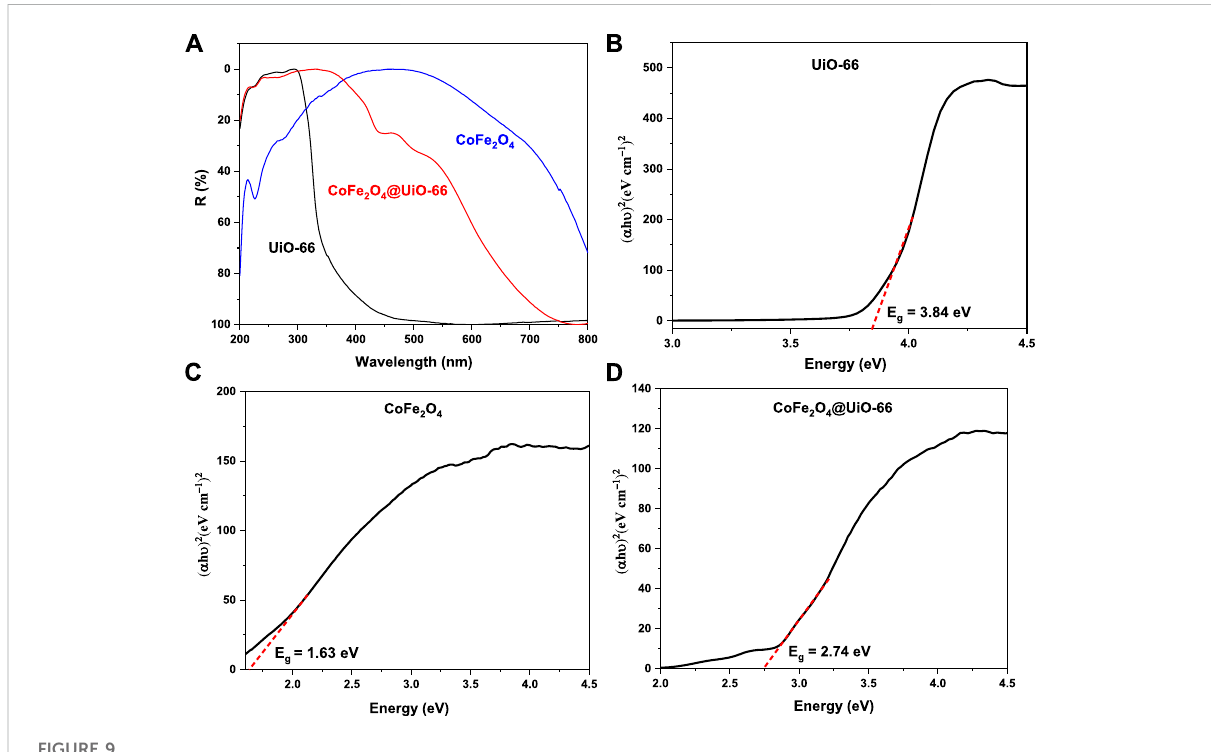
FIGURE 9 UV-vis DRS spectra (A) , bandgap (E g ) plots (B – D) of the as-synthesized